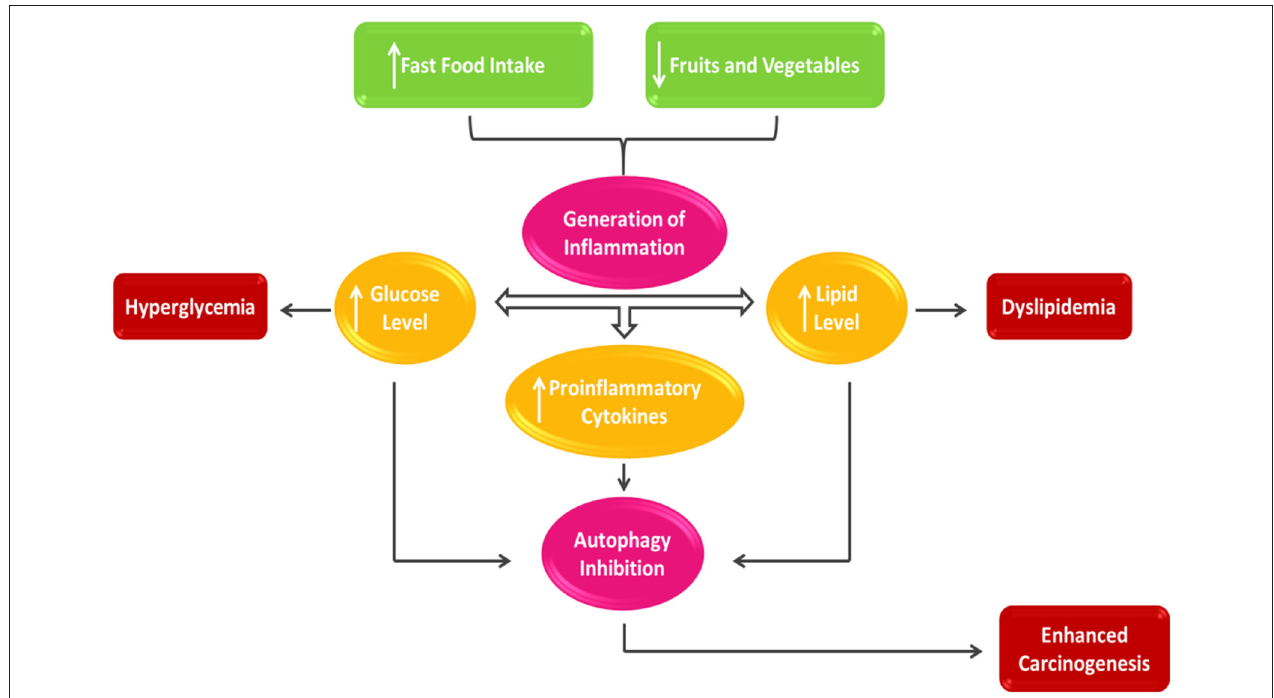
FIGURE 2 | Nutrient intake and cancer